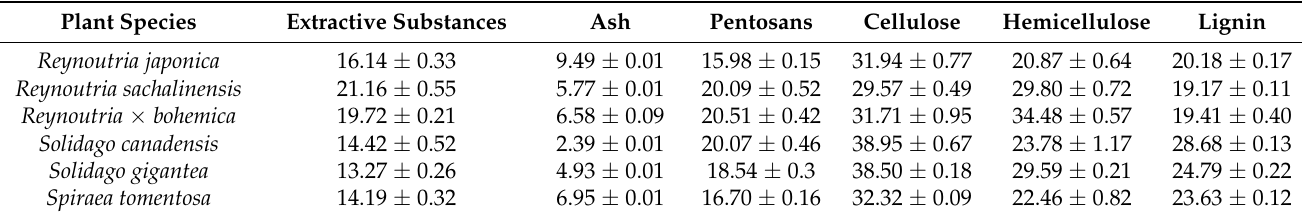
Table 1. The chemical composition of invasive plant species biomass (% of dry matter). Extractive